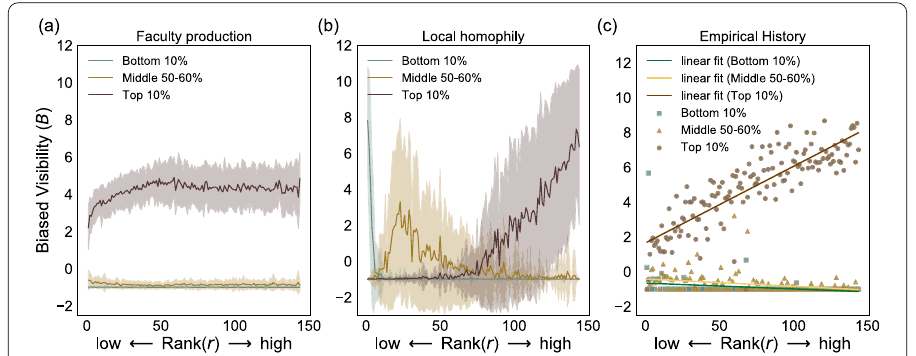
Figure S9 Biased visibility B for three groups of institutions (top 10%, middle 50–60%, and bottom 10%) as a function of perceiver institution’s rank r for two models and the empirical History network ( a ) The Faculty production model, ( b ) Local homophily model, and ( c ) the empirical History hiring network where each point is a department and lines indicate the best linear fit to the corresponding data. All models are from skewed initialization. Solid lines in ( a ), ( b ) denote the average over 50 networks ensembles, and the shaded region indicates the standard